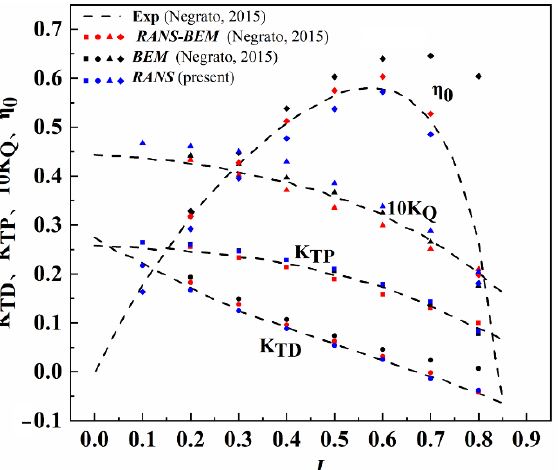
Figure 8. Open-water performance simulation results and comparison with literature [25] values.